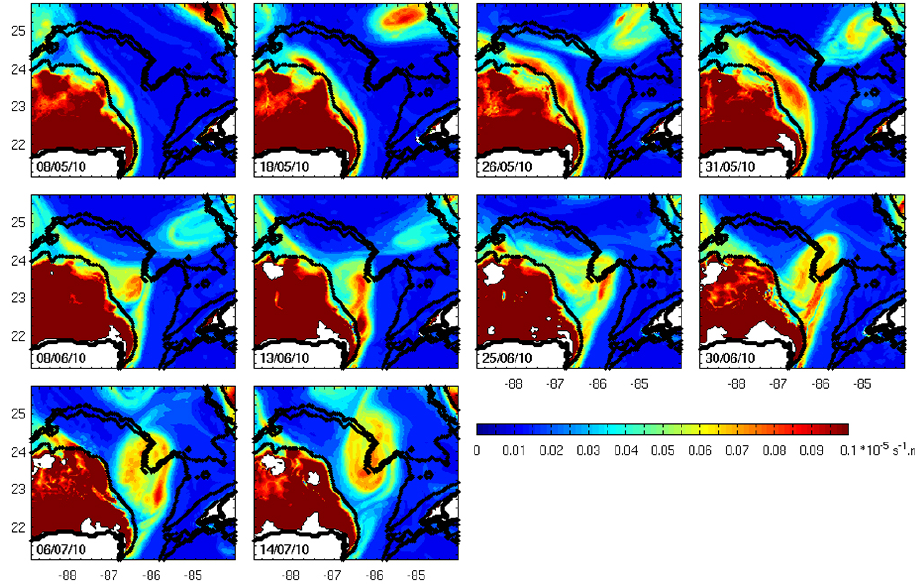
Figure 12. Snapshots of PV in layer 2 (of three-layer simplified analysis of model outputs), on 8, 18, 26, and 31 May; 8, 13, 25, and 30 June; 6 and 14 July 2010. Thick black lines are the 200, 2000, and 3000m isobaths. White patches are areas where layer 2 vanishes, which happens when there is no water of density in the range defining the simplified isopycnal layer 2 (see Appendix